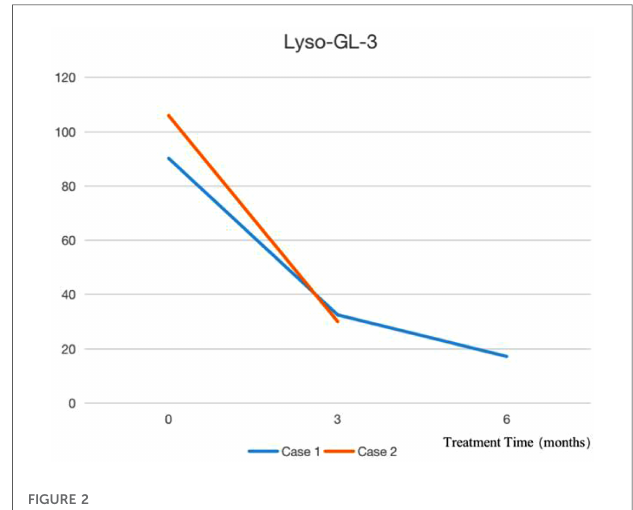
FIGURE 2 Indicators of lyso-GL-3 before and after